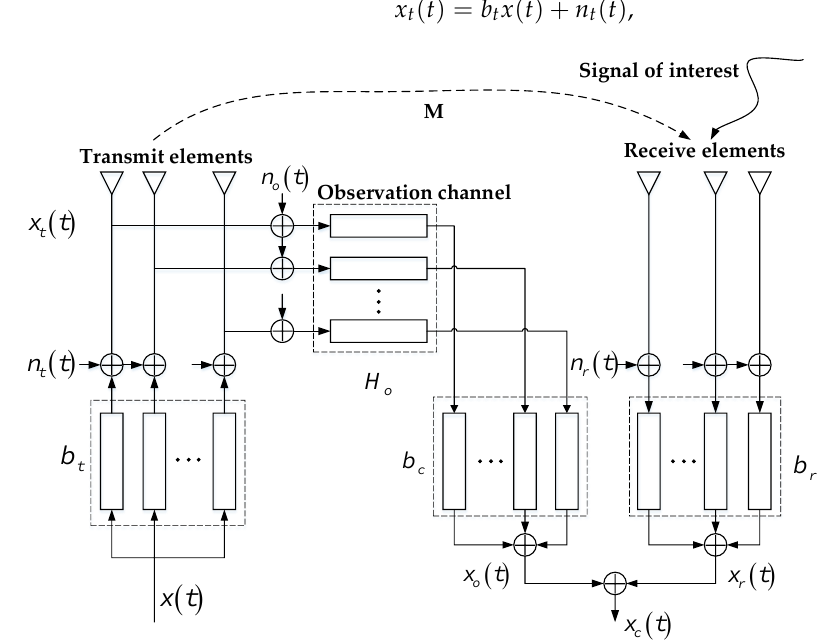
Figure 1. Block diagram of ALSTAR cancellation architecture.